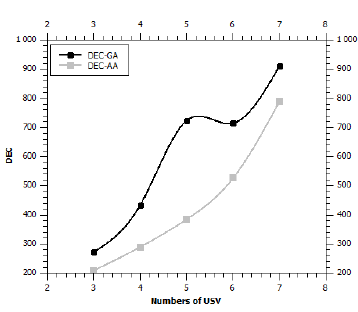
Figure 21: Displacement energy consump- tion in a zone with a low degrees of dirt.